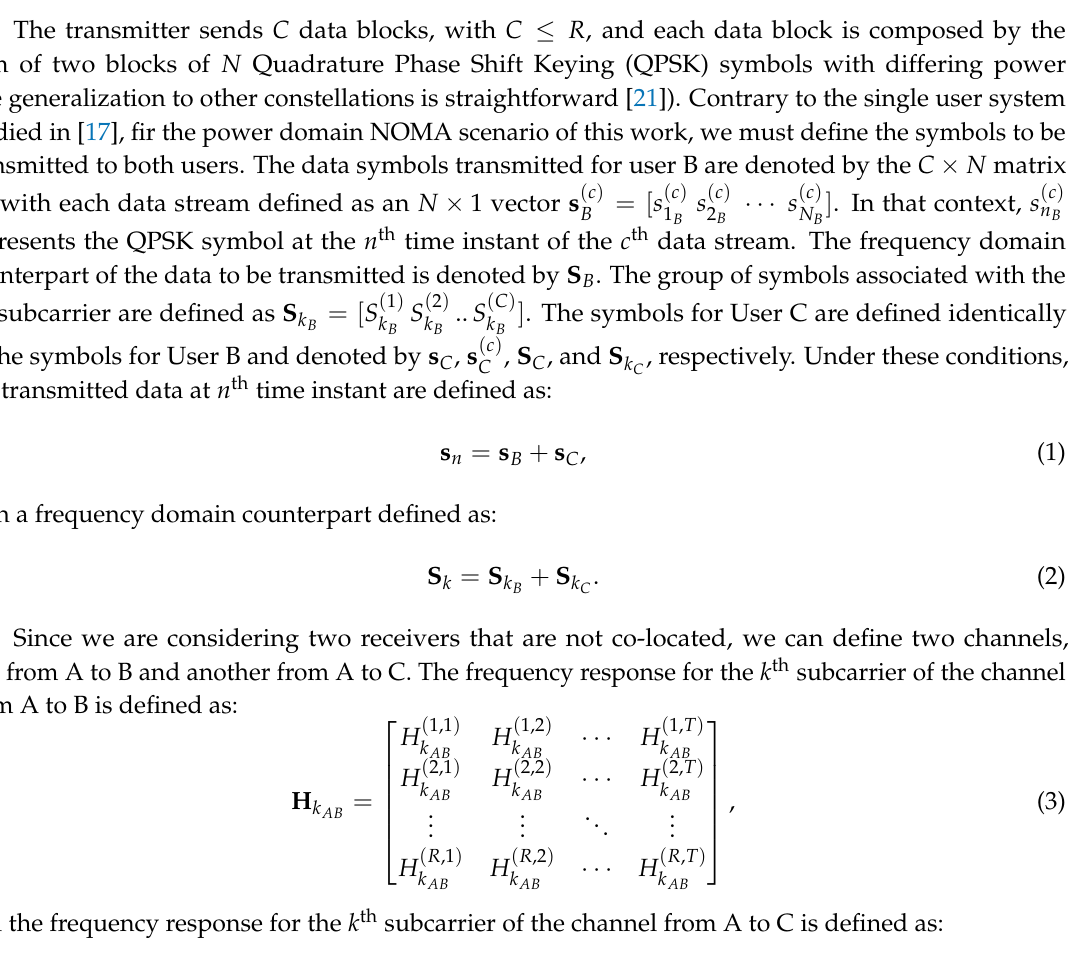
Figure 1. A diagram of the proposed NOMA scenario, with 3 users, 1 transmitting user and 2 receiving users, and 2